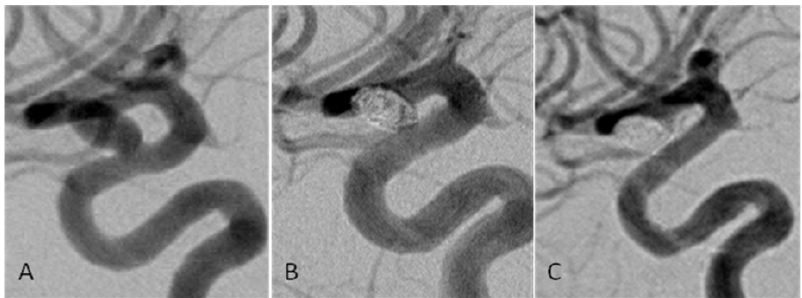
Figure 2. A 45 year old woman presented with double vision and subsequent angiographic imaging revealed bilateral aneurysms of the ICA of which one was located in the right paraophthalmic ICA measuring 4.2 mm. Figure 2A shows the aneurysm in the lateral view before treatment and immediately after stent-assisted coiling using a 4.5 6 22 mm Enterprise stent (B). Residual flow to the neck of the saccular aneurysm was noted on immediate post-treatment angiography. The 10 months follow-up imaging (C) revealed that the aneurysm underwent